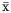
The most significant activity and inactivity structural features occurring in the Random-final model.(A) Structural features alerting for activity in the Random-final model. (B) Structural features alerting for inactivity in the Random-final model. The selection of activity features was based on a ranking by the formula |0.2 - x¯|∙ χ2, where x¯ is the mean activity of all training set structures containing the feature. The selection of inactivity features was done by significance (χ2) among the ‘pure’ inactivity features, i.e. only appearing in inactive substances. In both cases χ2 denotes Chi-square independence test with one degree of freedom with Yates’ correction.